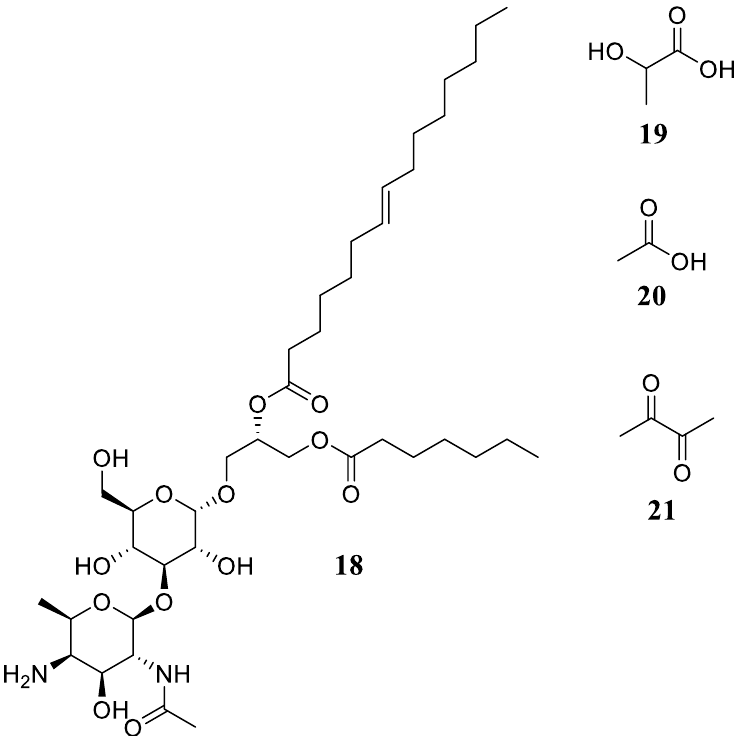
Figure 7. Chemical structures of lipoteichoic acid ( 18 ), lactic acid ( 19 ), acetic acid ( 20 ), and diacetyl ( 21 ) .